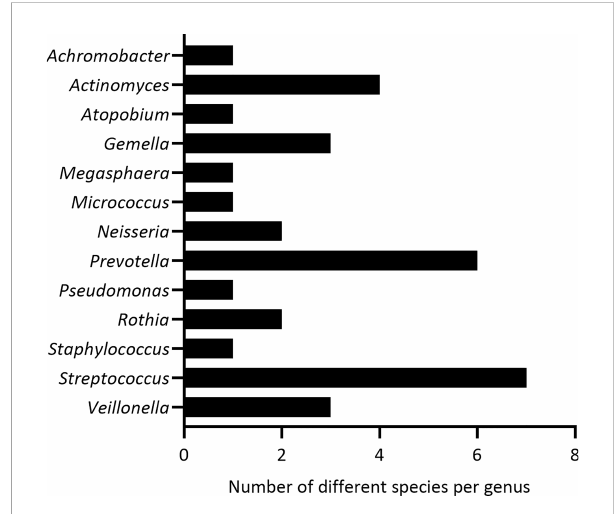
FIGURE 2 Identi fi ed genera and the number of bacterial species per genus, isolated from 5 sputum samples of